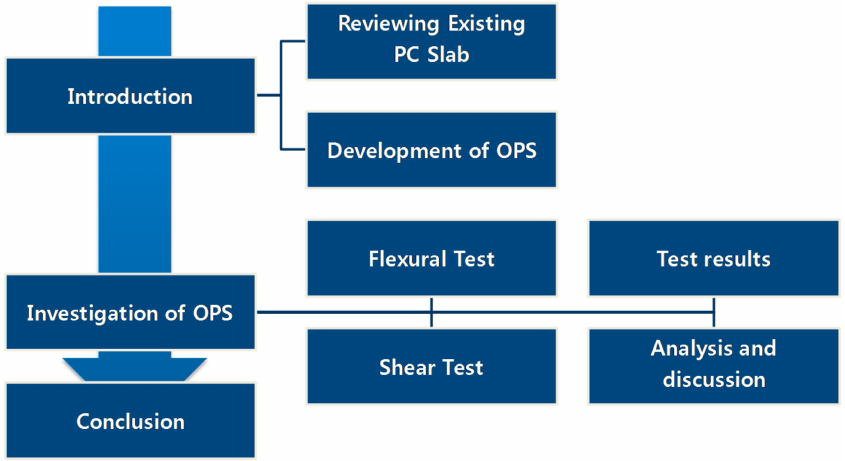
Figure 3. Framework of this